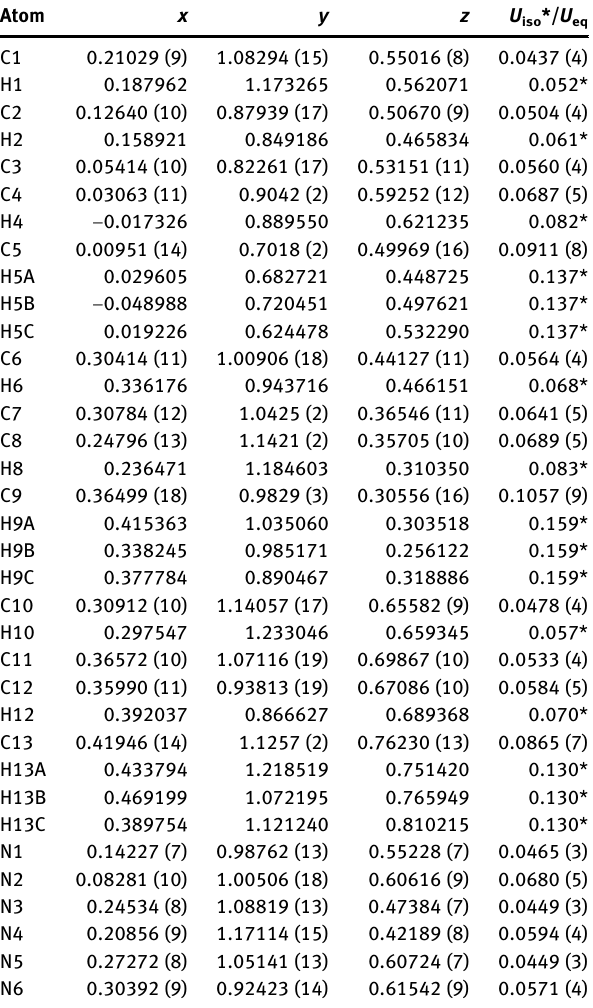
Table  : Fractional atomic coordinates and isotropic or equivalent isotropic displacement parameters (Å 